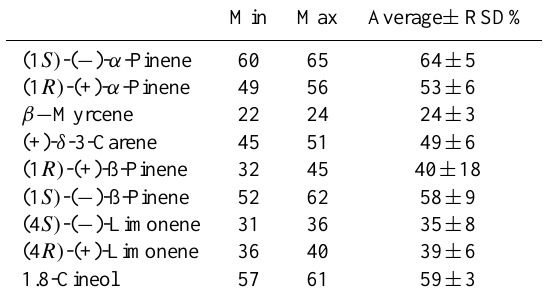
Table 5. Average monoterpene mixing ratios (pptv) of monoter- penes present in the ambient air outside MPIC (Mainz, Germany) sampled with SPME, 14–15 August